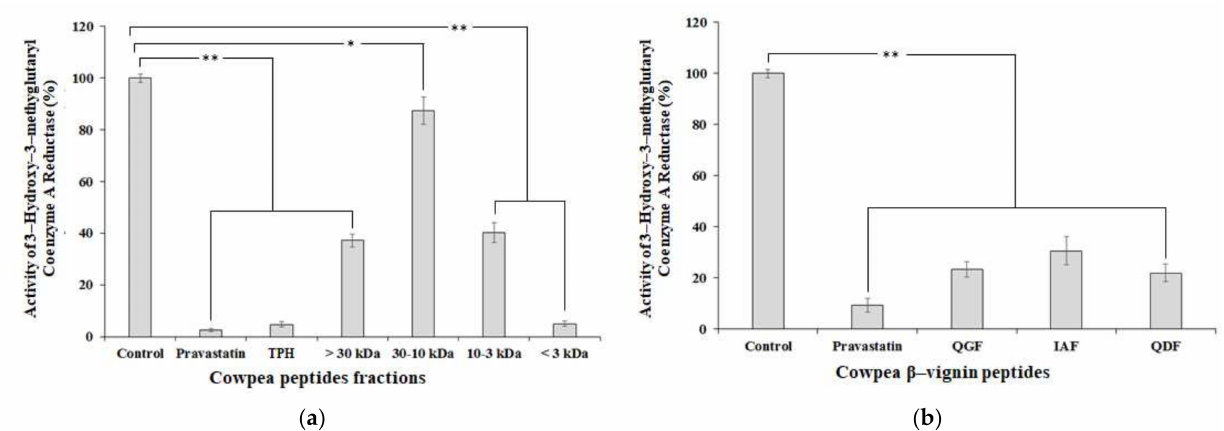
Figure 3. Inhibition of 3-hydroxy-3-methylglutaryl-coenzyme A reductase (HMG-CoAR) activity by ( a ) peptide fractions and ( b ) peptides on 5000 µ g/mL and 500 µ M concentrations, respectively. Mean value was significantly different: * p ≤ 0.05 and ** p ≤ 0.001 by Tukey’s multiple-range test. See text for experimental